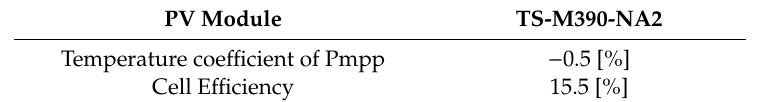
Table 1. Parameters for the photovoltaic (PV) module of Power Plants A and B.